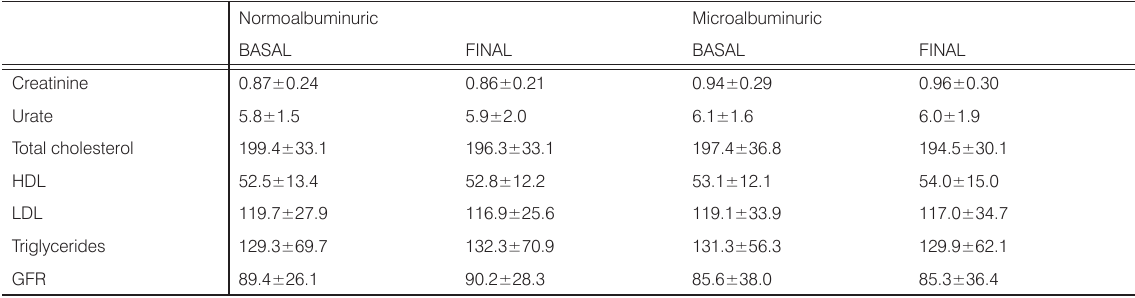
Table 4. Biochemical